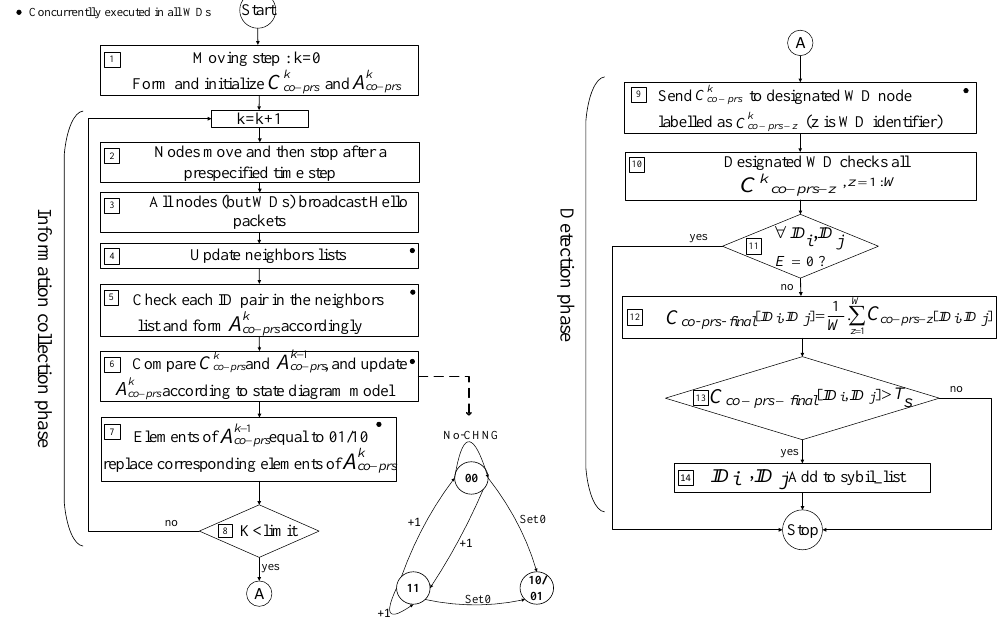
Figure 4. Flowchart of the proposed